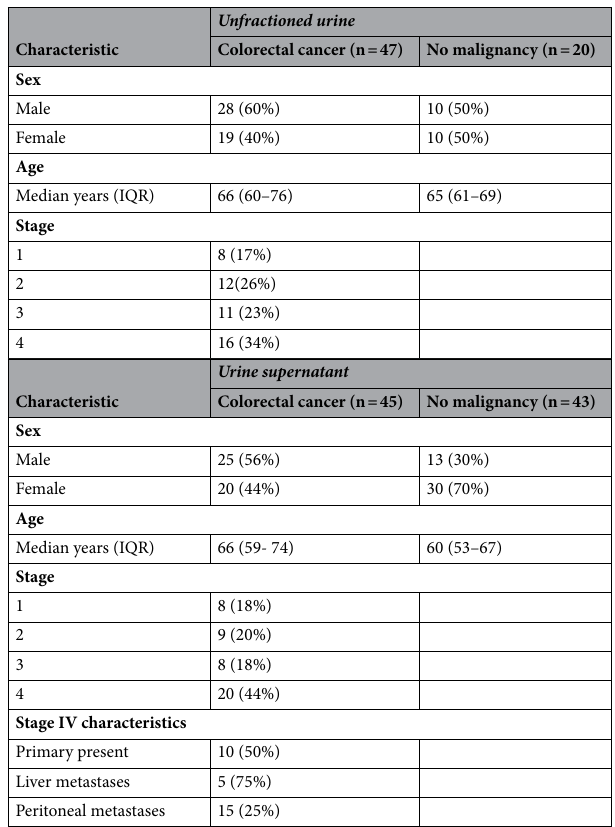
Table 1. Baseline and disease characteristics of CRC patients and controls.